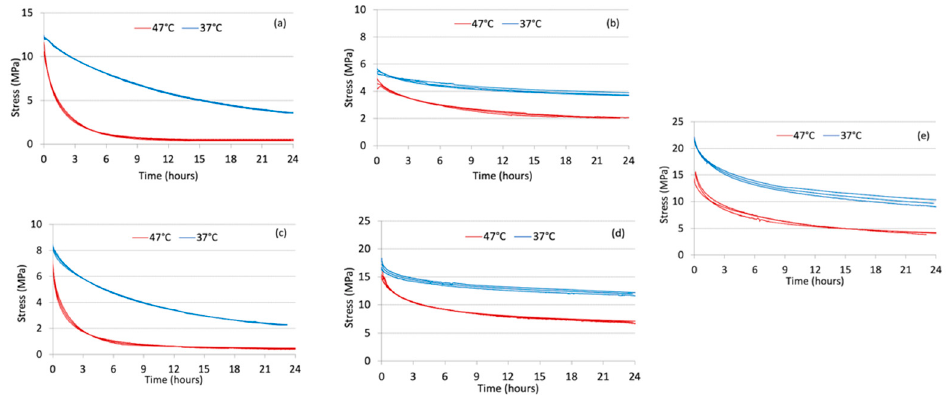
Figure 4. Stress relaxation curve: Duran ( a ), Erkoloc-Pro ( b ), Durasoft ( c ), F22 Evoflex ( d ), F22 Aligner ( e ).